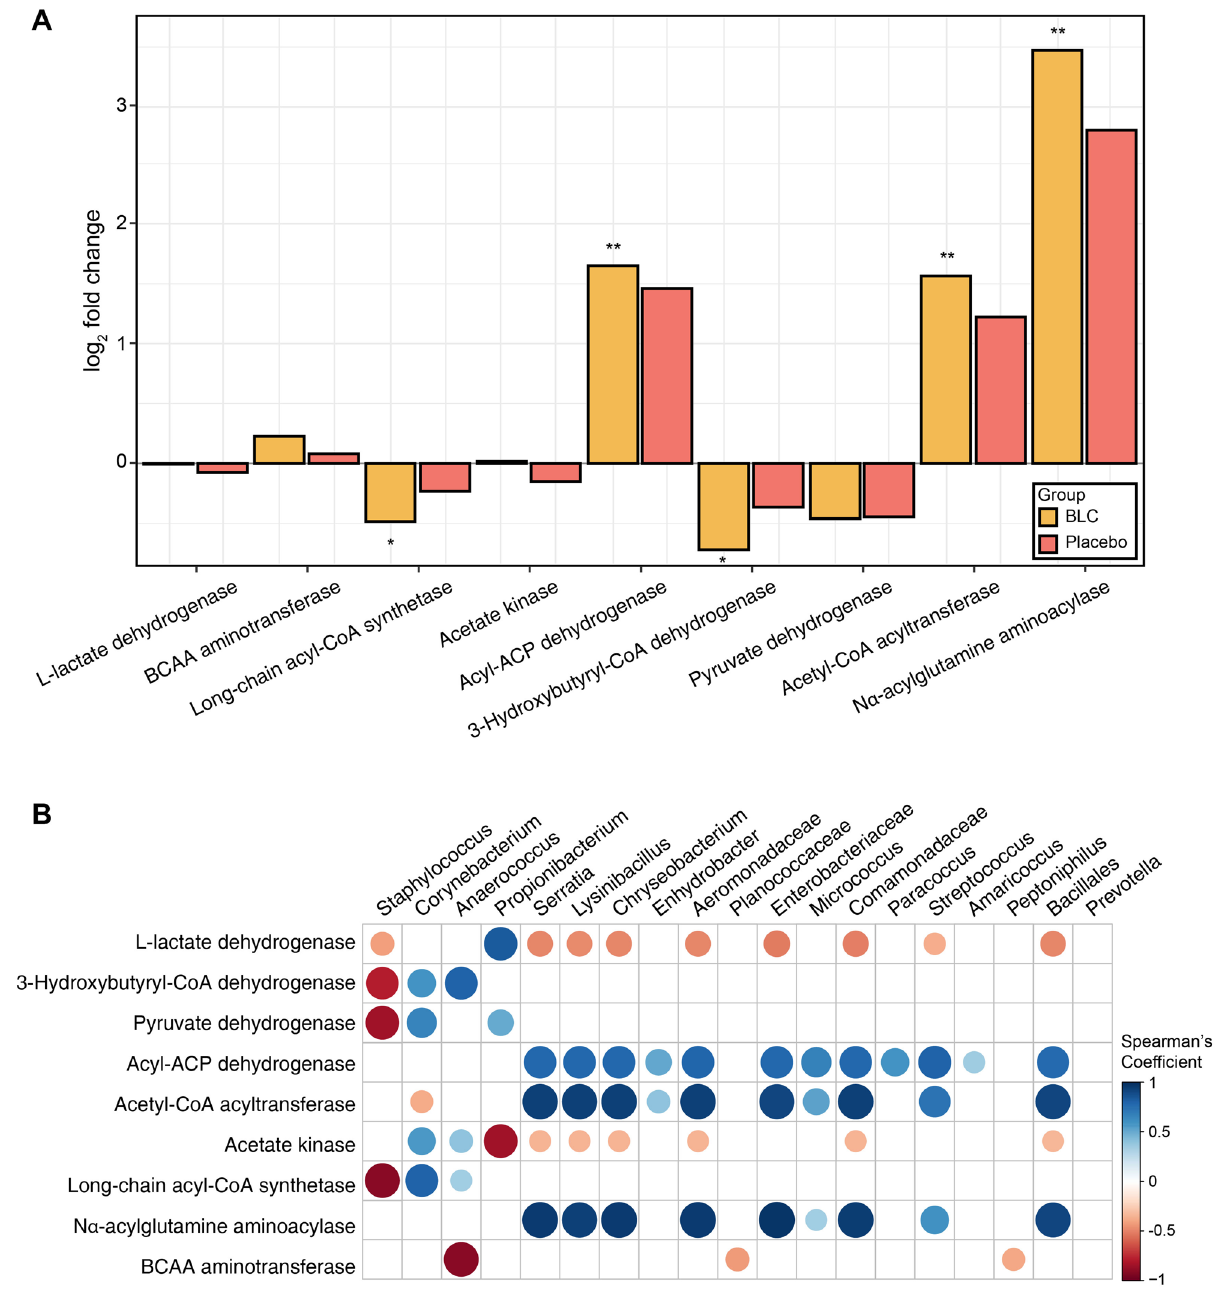
Figure 6. Functional gene prediction analysis of the axillary microbiome. ( A ) Log2-fold-change of odor-related genes in the bioconverted product (yellow) and placebo (red) group that represented changes at 1 week after using products in comparison with the baseline samples. False discover rate-adjusted values less than 0.05 and 0.01 are indicated with asterisks (* and **, respectively). ( B ) Correlation matrix showing a significant correlation ( p < 0.05) between the most abundant taxa and odor-related genes. The color code and size of the circles are the ρ correlation